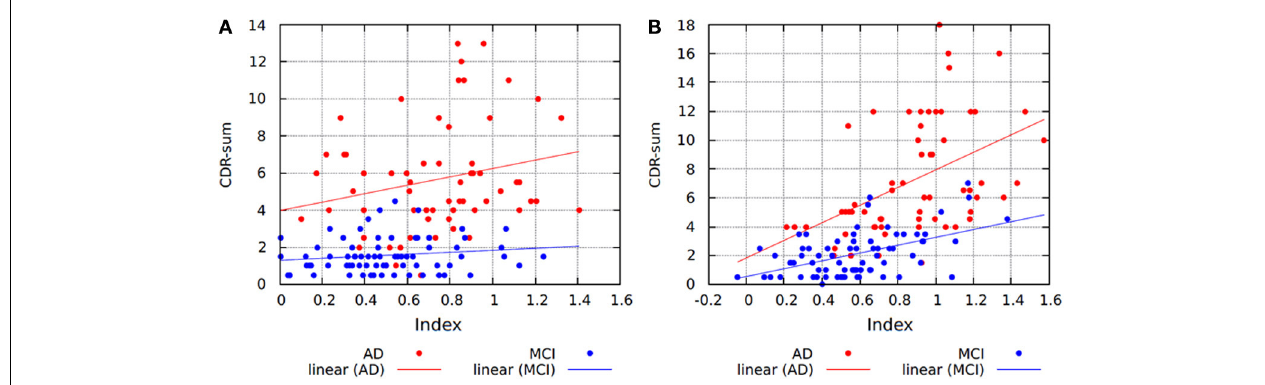
FIGURE 5 | Scatter plots and regression lines showing the relationship between the index and CDR-sum scores for (A) baseline and; (B) 1-year follow-up data. AD, Alzheimer disease; MCI, mild cognitive impairment; CDR-sum, clinical dementia rating sum of boxes.